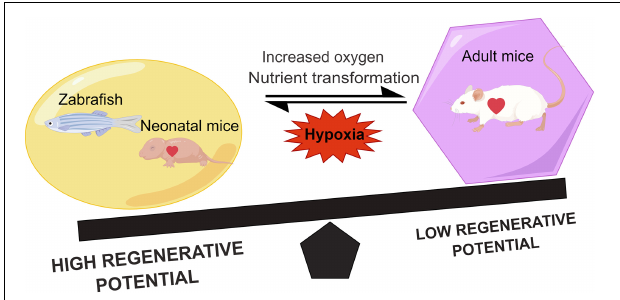
FIGURE 1 | Comparison of the regenerative capacity of representative lower vertebrates, neonatal, and adult mammals. Hypoxia can promote heart regeneration and increase the regenerative capacity. During the growth of neonatal mice, the shift in metabolic state of the heart due to the increased oxygen and nutrients leads to a decrease in the myocardial regenerative